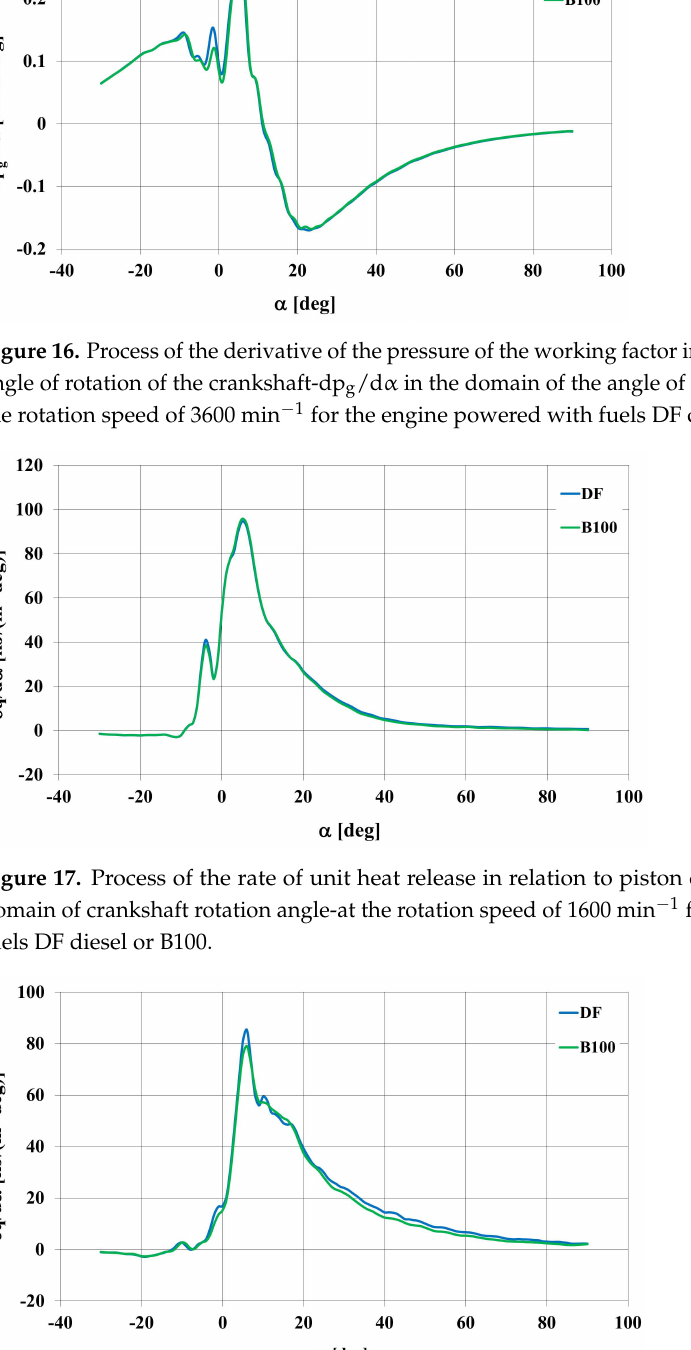
Figure 18. Process of the rate of unit heat release in relation to piston displacement- δ q/d α in the domain of crankshaft rotation angle-at the rotation speed of 3600 min − 1 for the engine powered with fuels DF diesel or